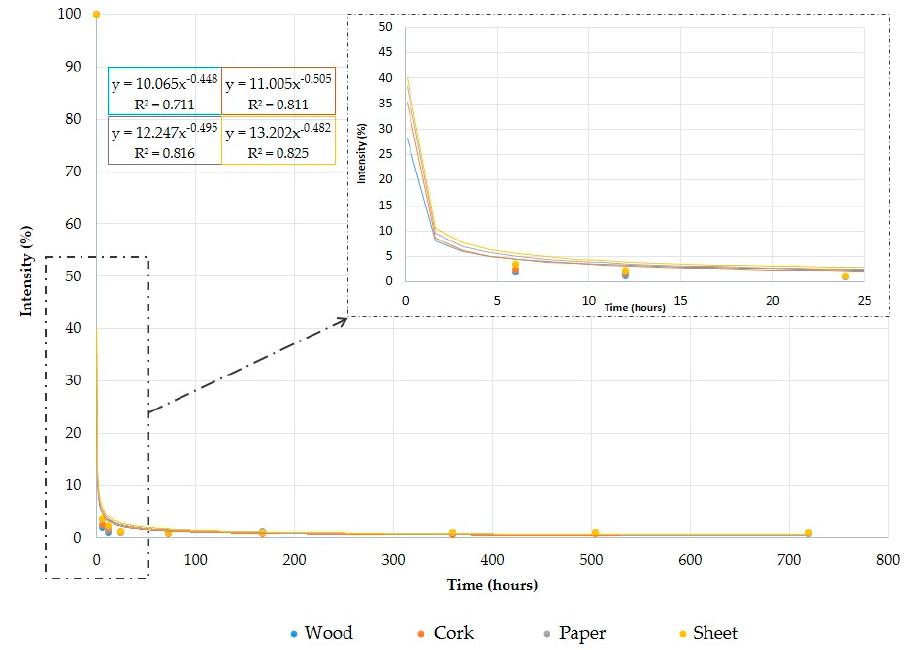
Figure 4. Analysis of the degradation rate for 80 µL of gasoline on different supports.